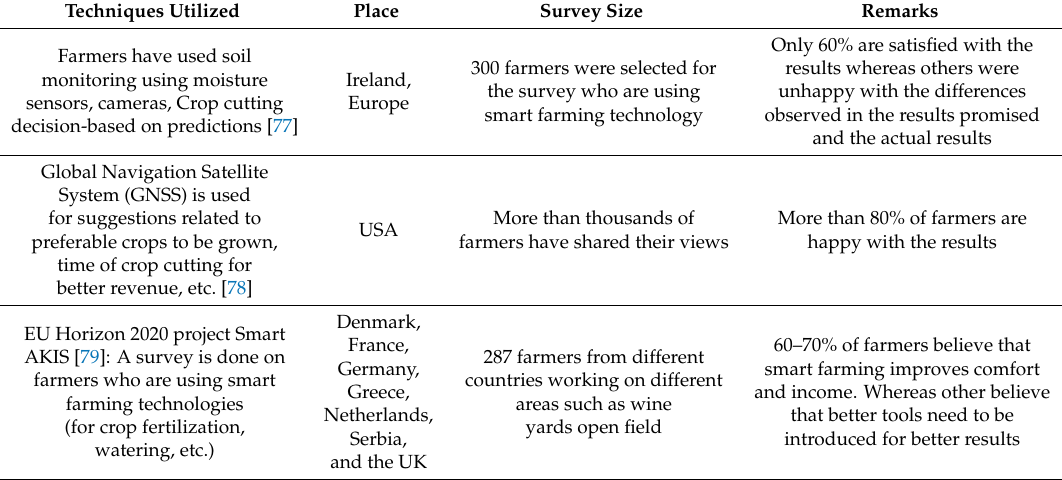
Table 3. Various surveys on accepting smart farming technology by